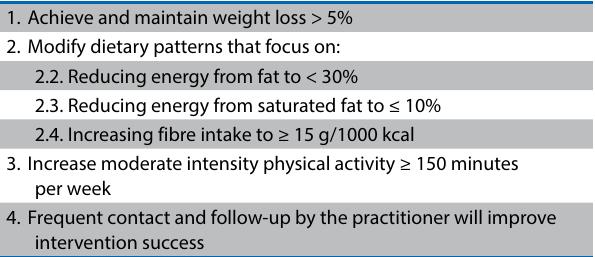
Table 10: Key components of a successful lifestyle modification programme for patients with IFG or IGT 45